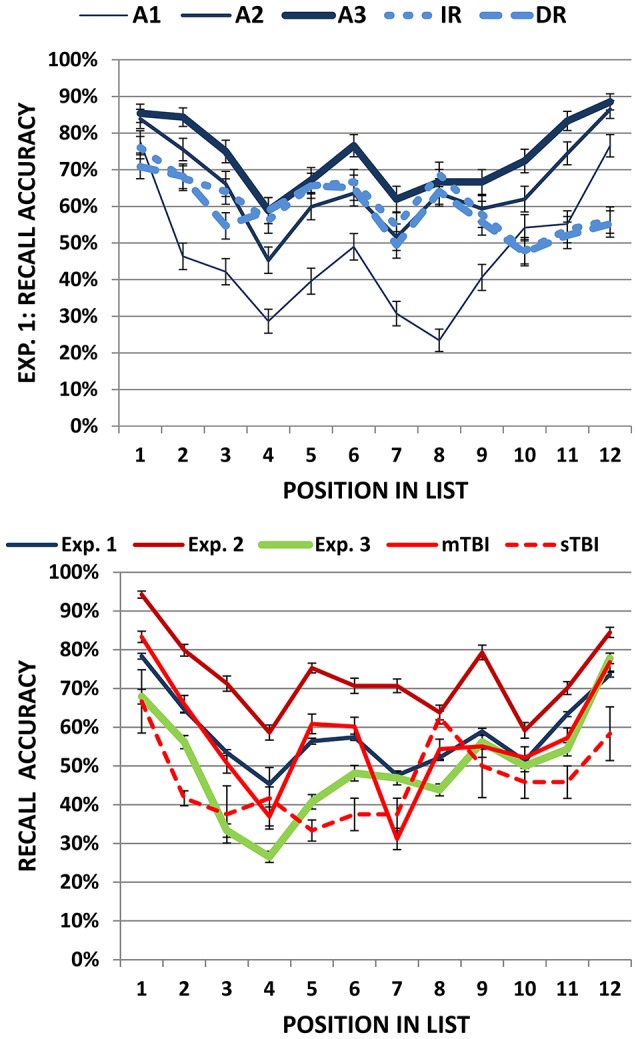
Top: Serial position functions in Experiment 1 shown separately for learning (A1, A2, and A3) and recall trials (IR and DR). Bottom: Serial position functions averaged over learning and recall trials for all experiments. Error bars show standard errors. See Figure 2 for abbreviations.